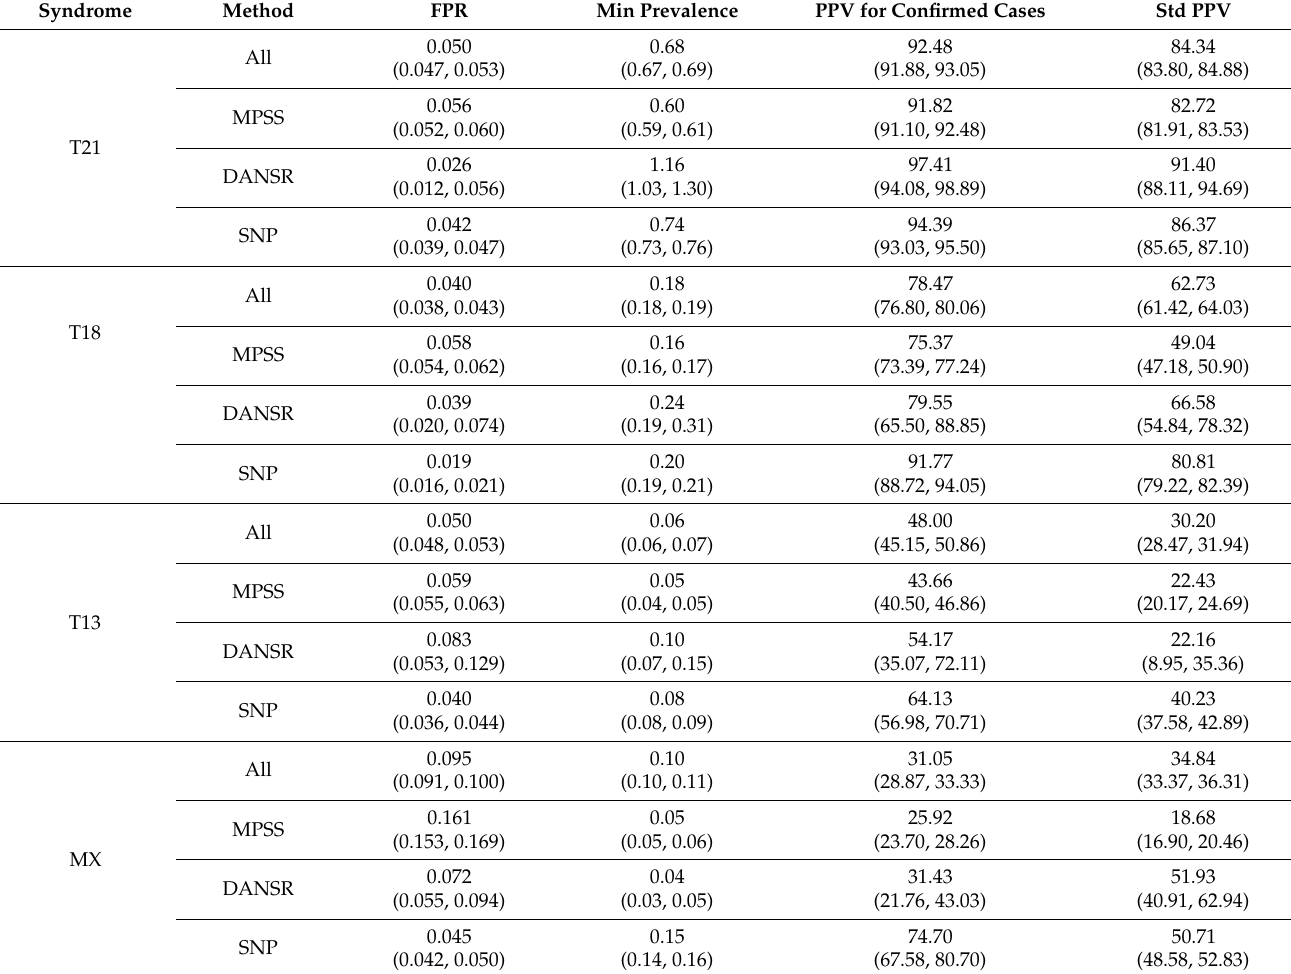
Table 6. Clinical experience studies: pooled estimates by syndrome and method of